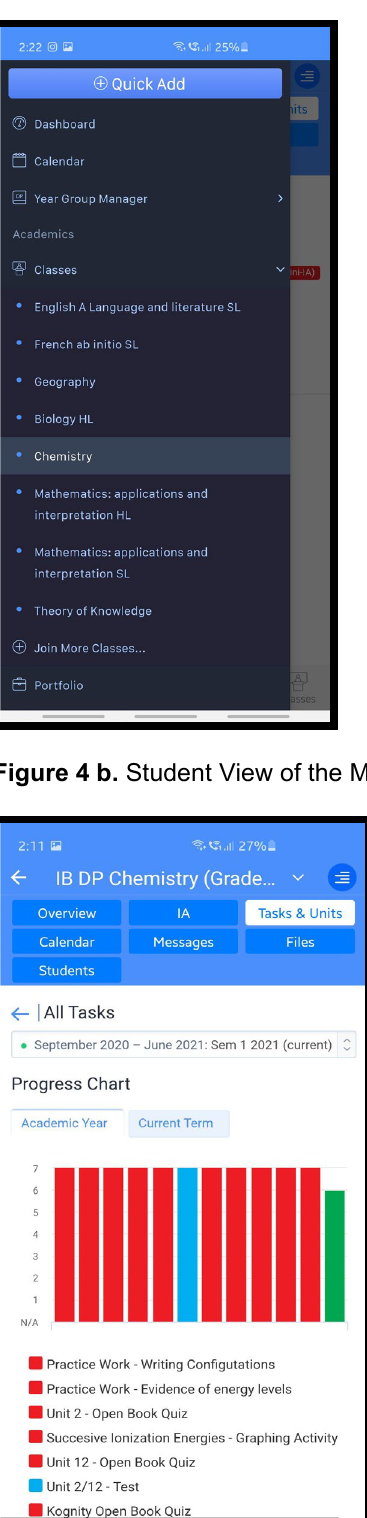
Figure 4 a. Student View of the Dashboard